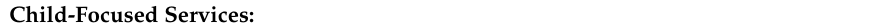
Table 2. Child-focused